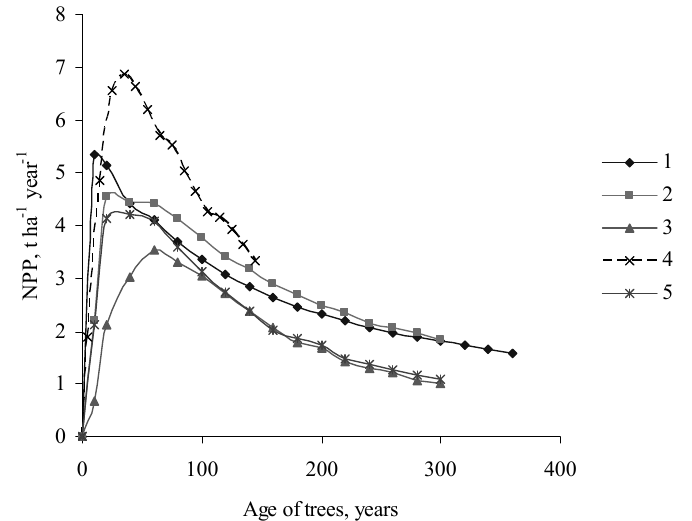
Forests 2018 , 9 , x FOR PEER REVIEW